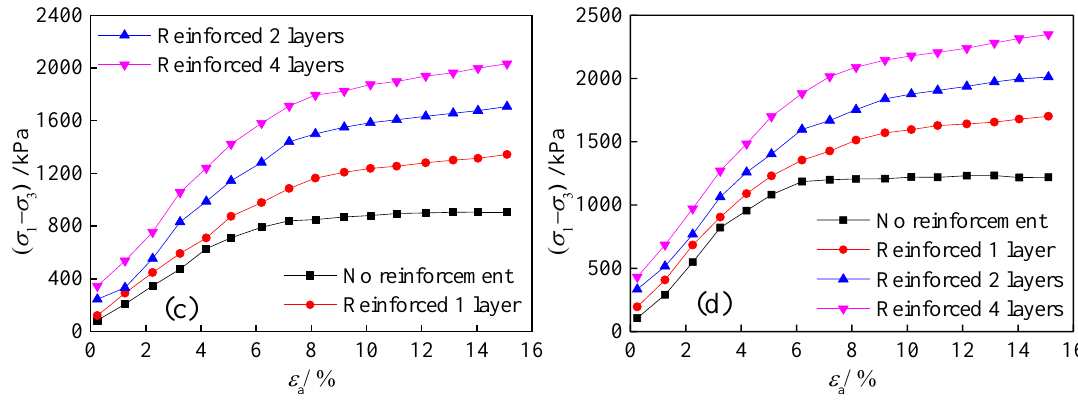
Figure 4. Stress–strain curves of reinforced tailings under different reinforced layers of geogrids: ( a ) Confining pressure 100 kPa, ( b ) confining pressure 200 kPa, ( c ) confining pressure 300 kPa, and ( d ) confining pressure 400 kPa.